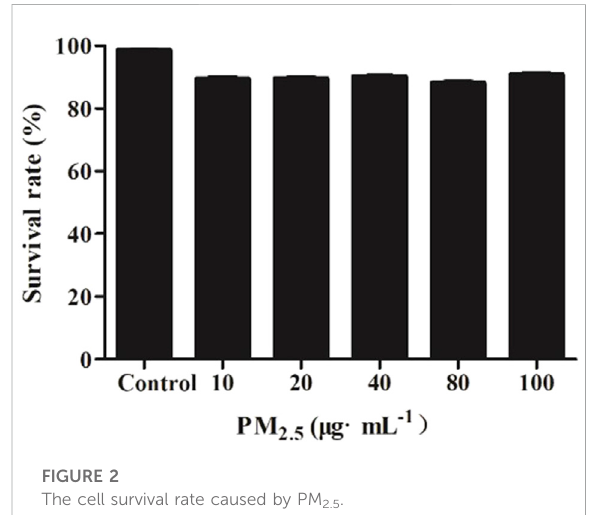
The cell survival rate caused by PM 2.5